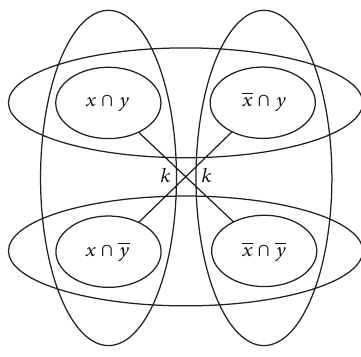
Figure 4: Intersecting cuts 𝑥 and 𝑦 .